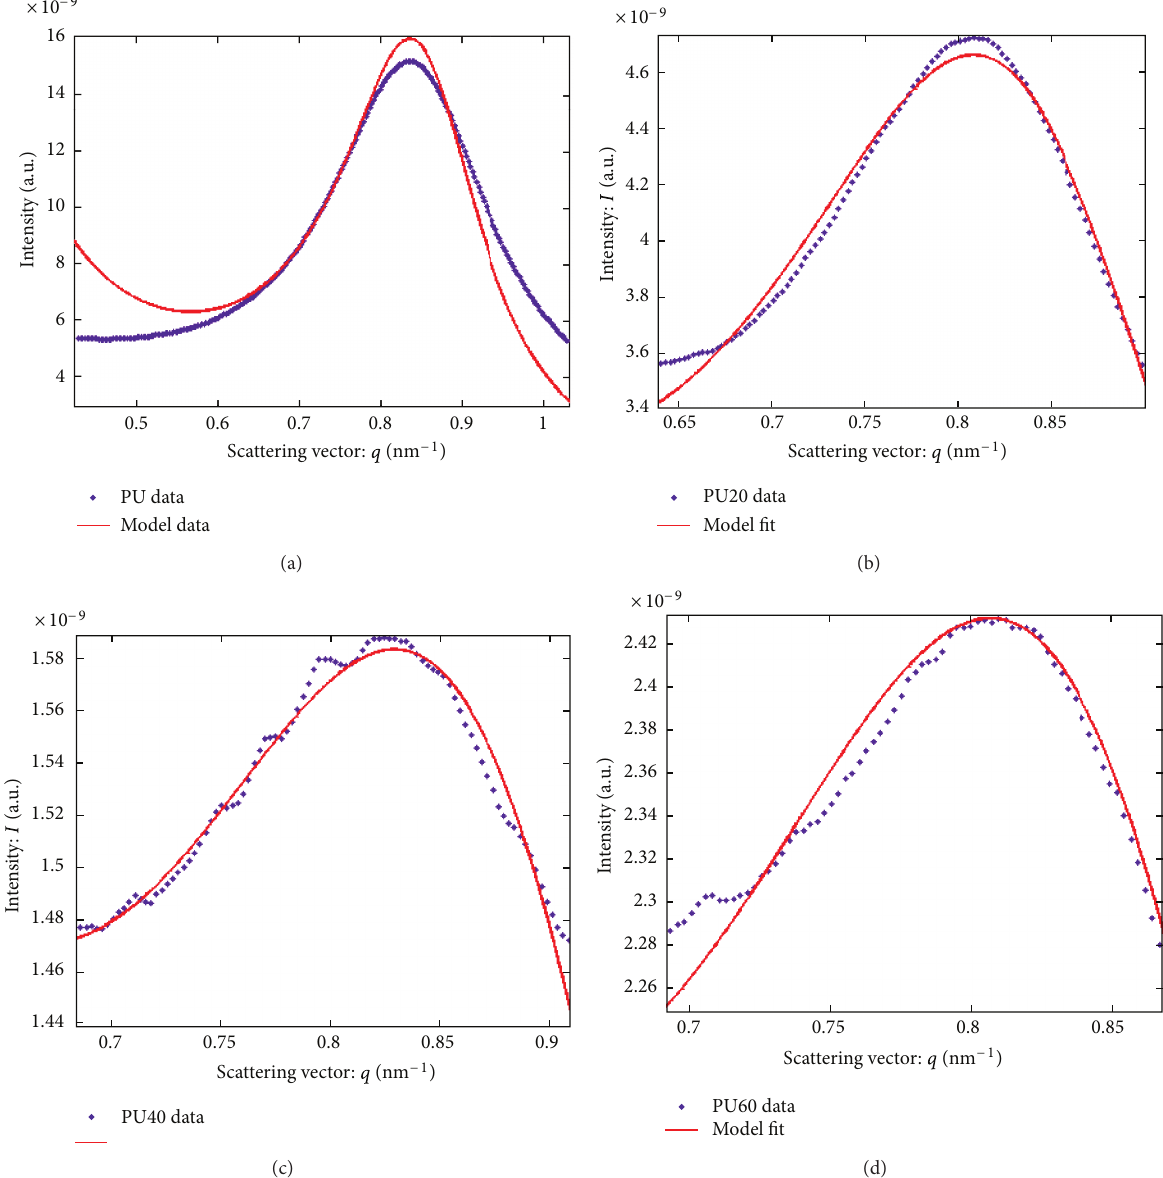
F 3: Curve �tting according to the lamellar model for �� composites loaded with (a) �, (b) 2�, (c) ��, and (d) ��wt.